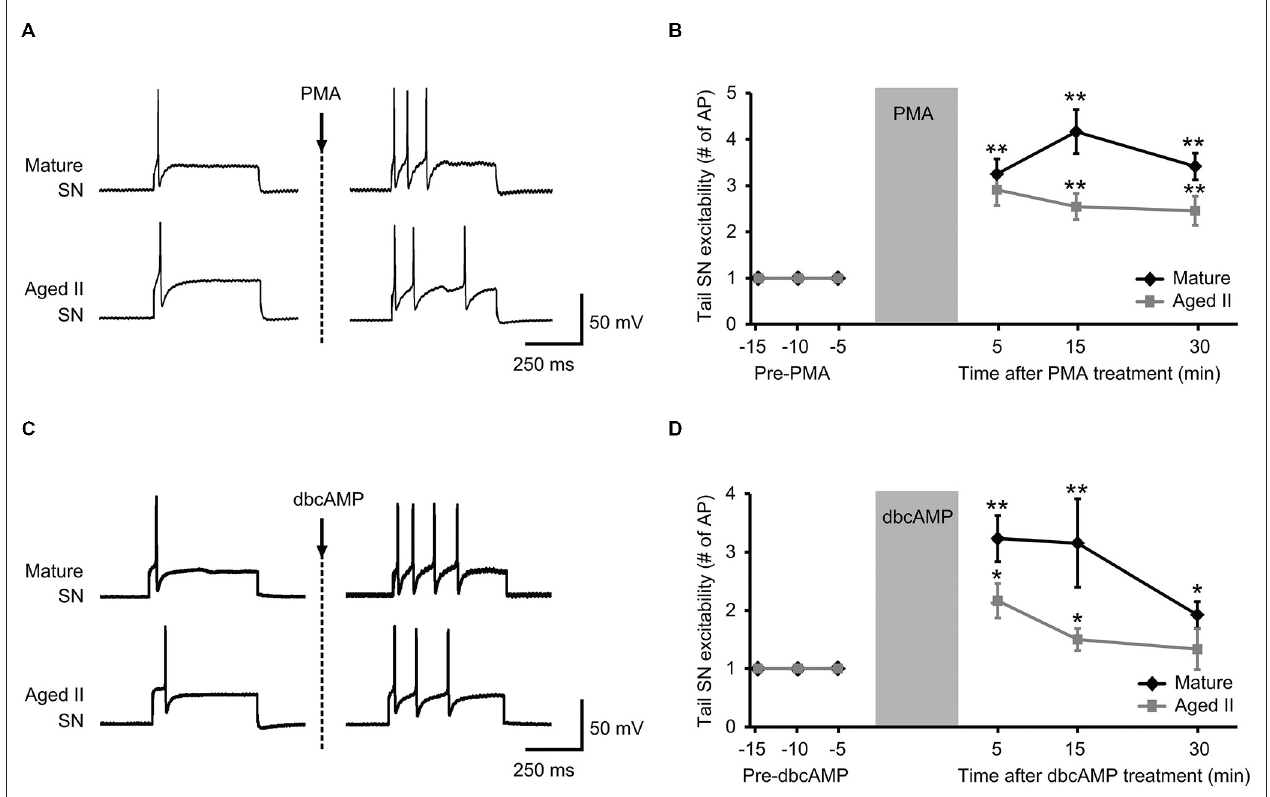
FIGURE 3 | Treatment with activators of PKA and PKC signaling rescued aged II SN performance in semi intact preparation. (A) Representative responses in mature and aged II tail SN during depolarizing current injection before and 5 min after the end of 10 min PMA perfusion (50 nM) onto the pleural-pedal ganglion. Mature and aged II neurons were maintained at a holding potential of − 43 mV during the experiment. (B) In both mature ( n = 12) and aged II ( n = 11) tail SN, the number of AP in response to depolarizing current injection was significantly increased at 5, 15, and 30 min following the end of PMA treatment. ( ∗∗ ) denotes significant increase compared to baseline at p ≤ 0.01, Tukey’s post hoc tests. (C) Responses in mature and aged II tail SN before and 5 min after dbcAMP perfusion (20 µ M). Mature and aged II neurons were maintained at a holding potential of − 43 mV during the experiment. (D) In both mature ( n = 13) and aged II ( n = 12) tail SN, the number of AP in response to depolarizing current injection was significantly increased at 5 and 15 min following dbcAMP treatment. At 30 min after the end of dbcAMP application, excitability of mature SN was still enhanced, while aged II SN excitability had returned to baseline value. ( ∗ ) and ( ∗∗ ) denotes significant increase compared to baseline at p ≤ 0.05 and p ≤ 0.01, respectively, Tukey’s post hoc